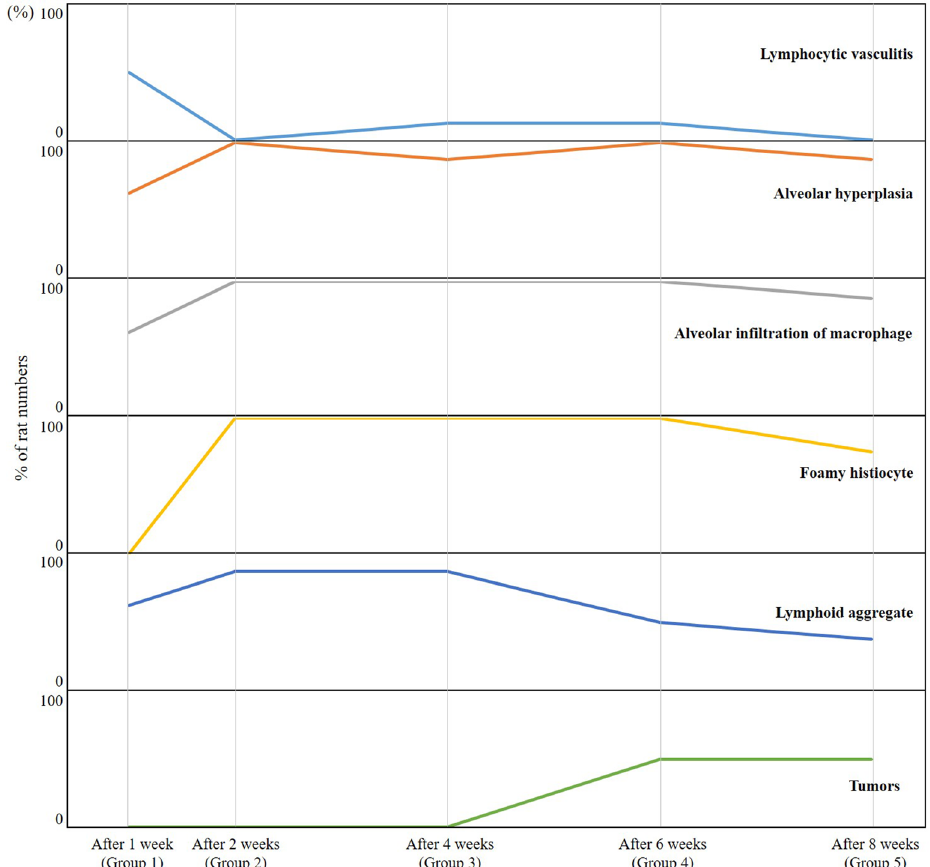
Figure 2. Changes in the pathologic findings according to group. Lymphocytic vasculitis was prominent 1 week after PHMG exposure and then decreased ( p = 0.057, P-value for trend = 0.028). Alveolar hyperplasia peaked at 6 weeks after PHMG exposure and then decreased ( p = 0.001, P-value for trend = 0.034). Alveolar infiltration of macrophages was observed continuously over all weeks ( p = 0.078, P-value for trend = 0.884). Foamy histiocyte and lymphoid aggregate peaked at 4 weeks after PHMG exposure and then decreased (all p < 0.05, all P-value for trend > 0.05). Tumors were found in 50% of rats (4 of 8 rats) at 6 weeks and 50% of rats (4 of 8 rats) at 8 weeks after PHMG exposure (all p < 0.001, all P-value for trend <